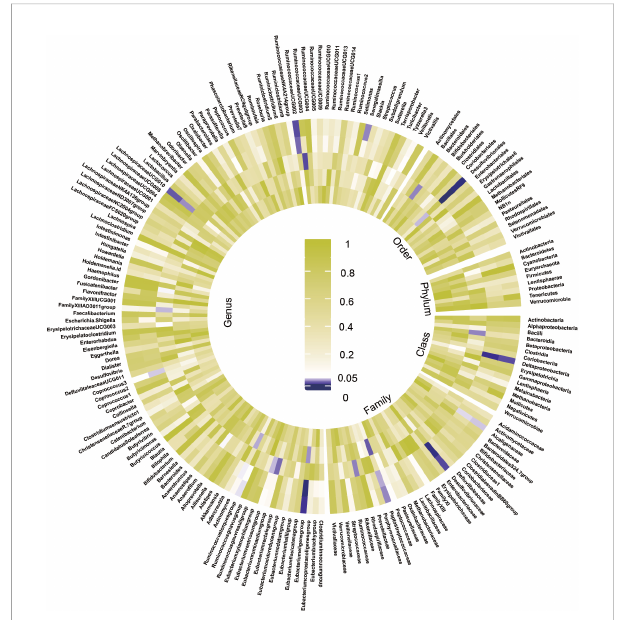
FIGURE 2 Preliminary MR estimates for the associations between gut microbiota and the risk of CKD. From the inner to outer circles, they represent the estimates of: mode-based estimation, weighted median, MR-Egger, MR-PRESSO and inverse-variance weighted methods, respectively. And the shades of color re fl ect the magnitude of the